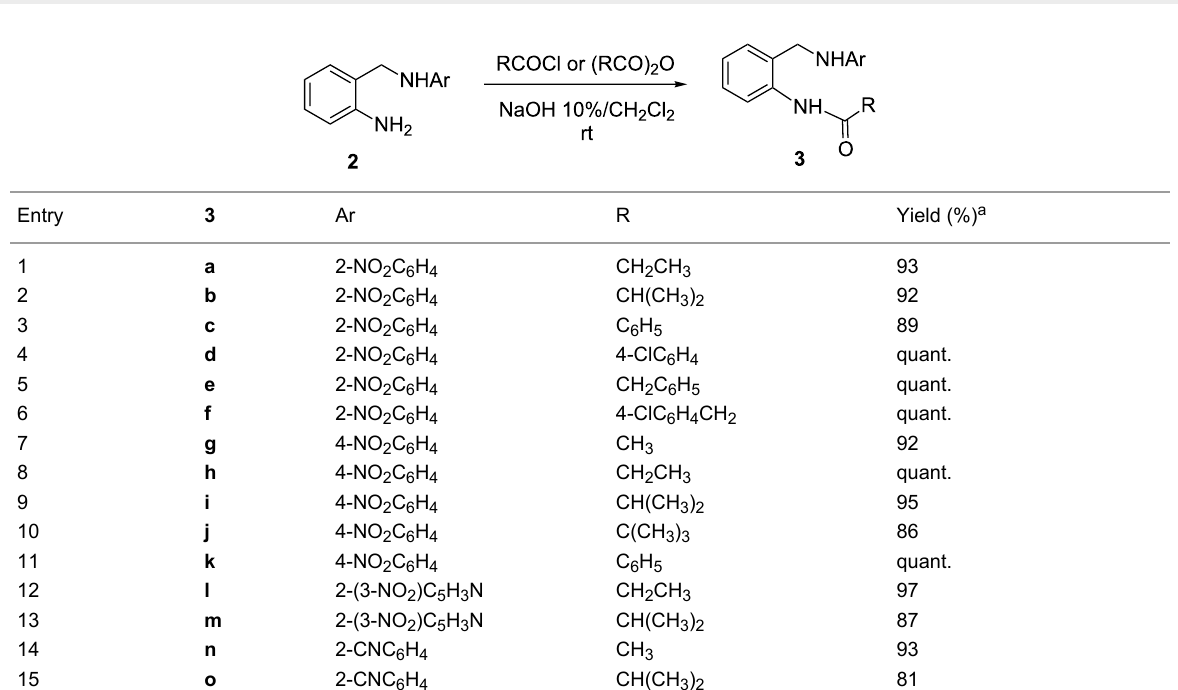
Table 2: Selective N -acylation of N- aryl-2-ABAs 2